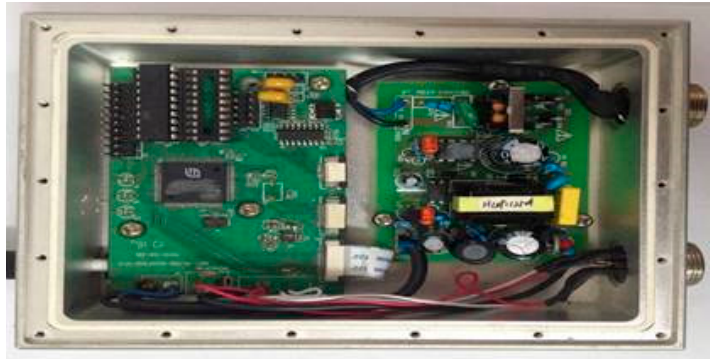
Figure 9. Internal structure of data station.